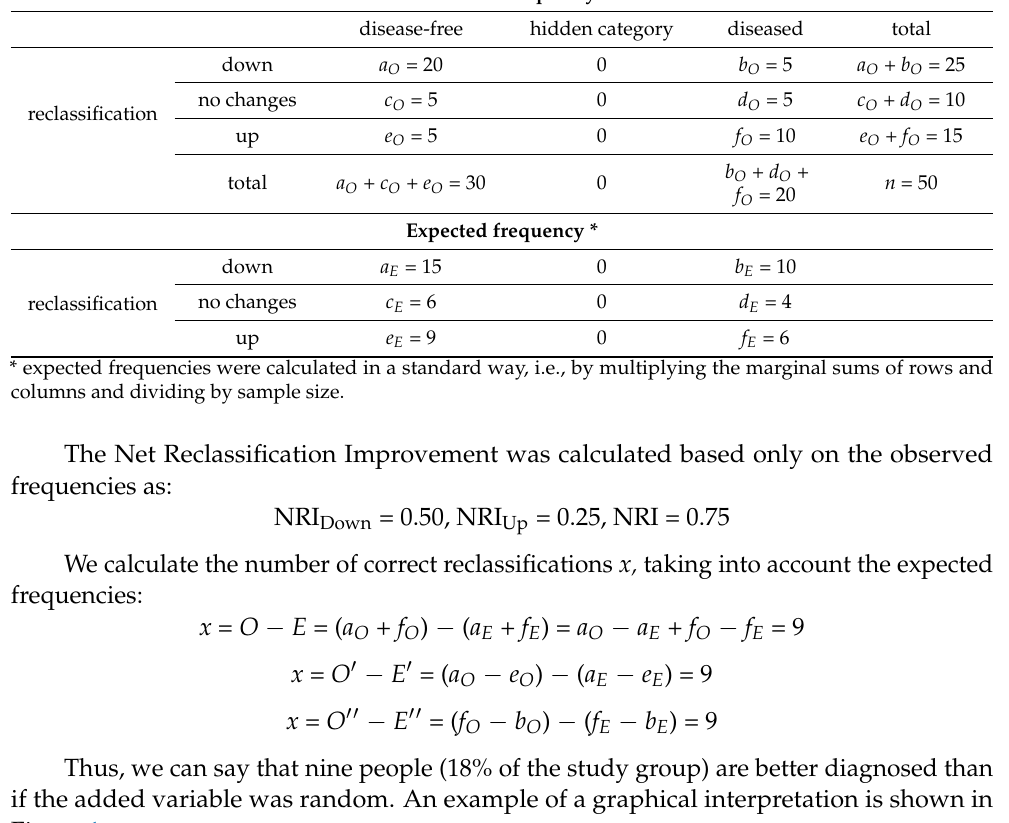
Table 3. Observed reclassification to the group of people who were diagnosed with a disease and the group of disease-free individuals, and the numbers expected random reclassification using a 50-element sample.